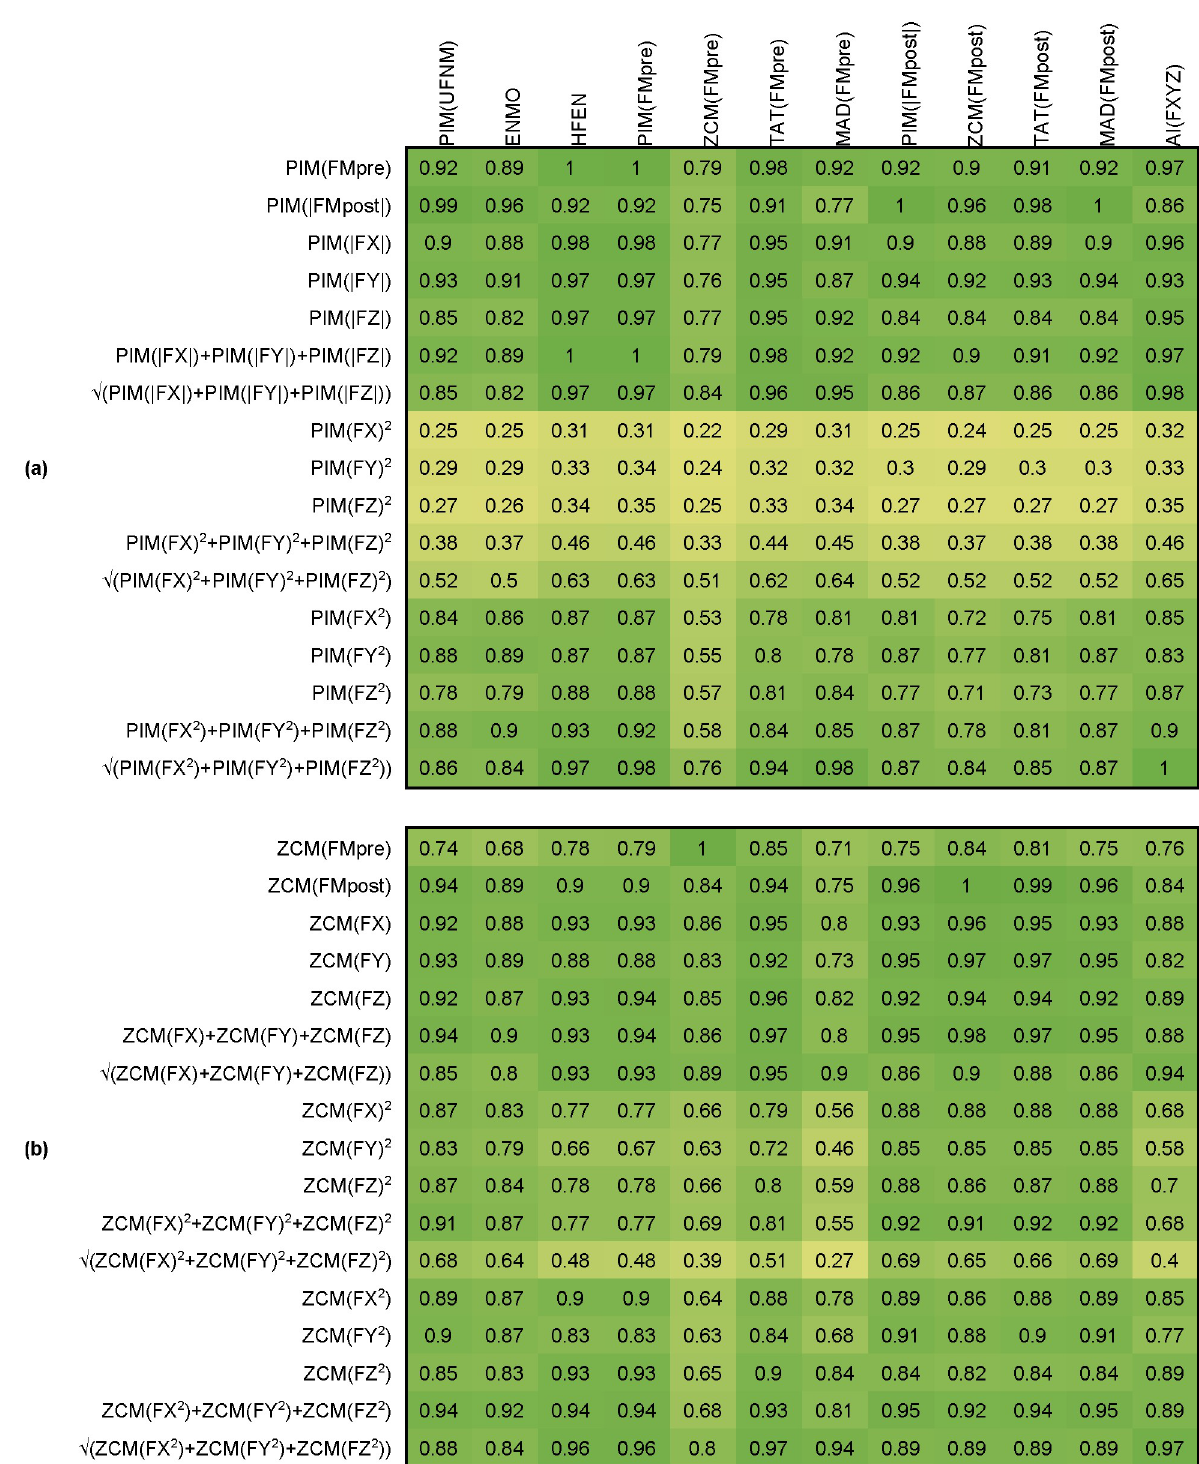
Fig 11. Correlation between new activity indicators based on the activity signals determined per axis using PIM (a), ZCM (b) metrics and the 7 metrics applied on filtered vector magnitudes (FMpost, FMpre, FXYZ). Each cell contains the Pearson’s correlation coefficient between the two corresponding activity signals. The coefficients are calculated by 42 measurements, and their means are represented.